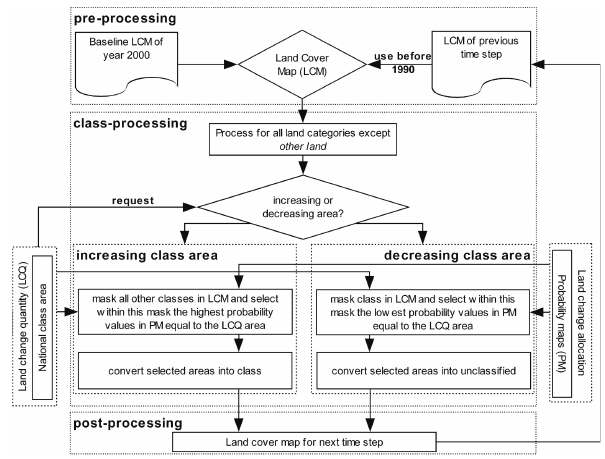
Fig. 2. Exemplary workflow of the model approach for one